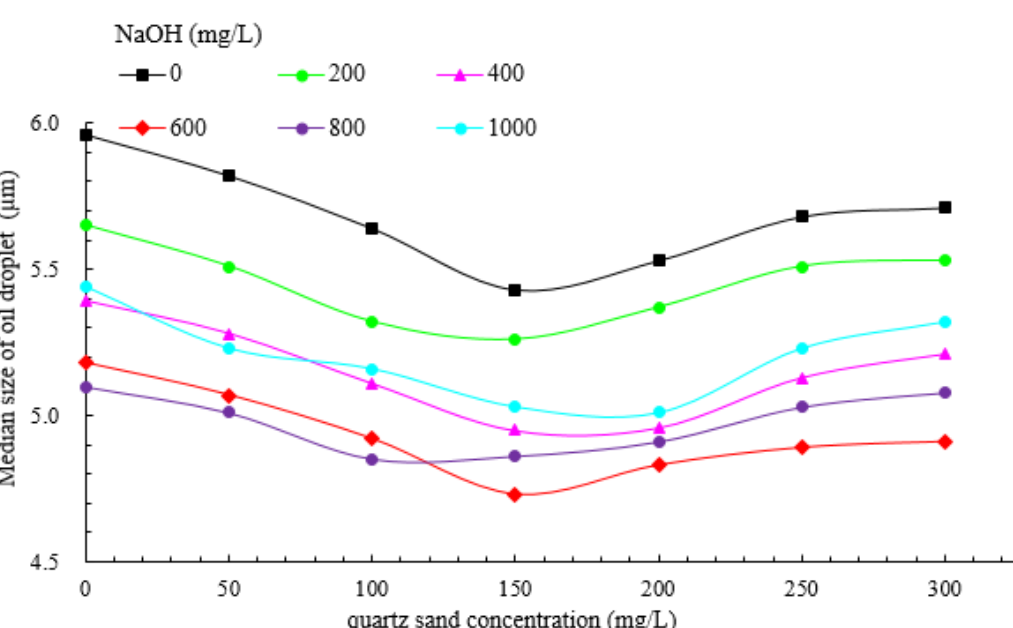
Figure 12. The synergetic effect of quartz sand particles and alkali on oil droplets size (polymer concentration 500 mg/L, surfactant concentration 200 mg/L).